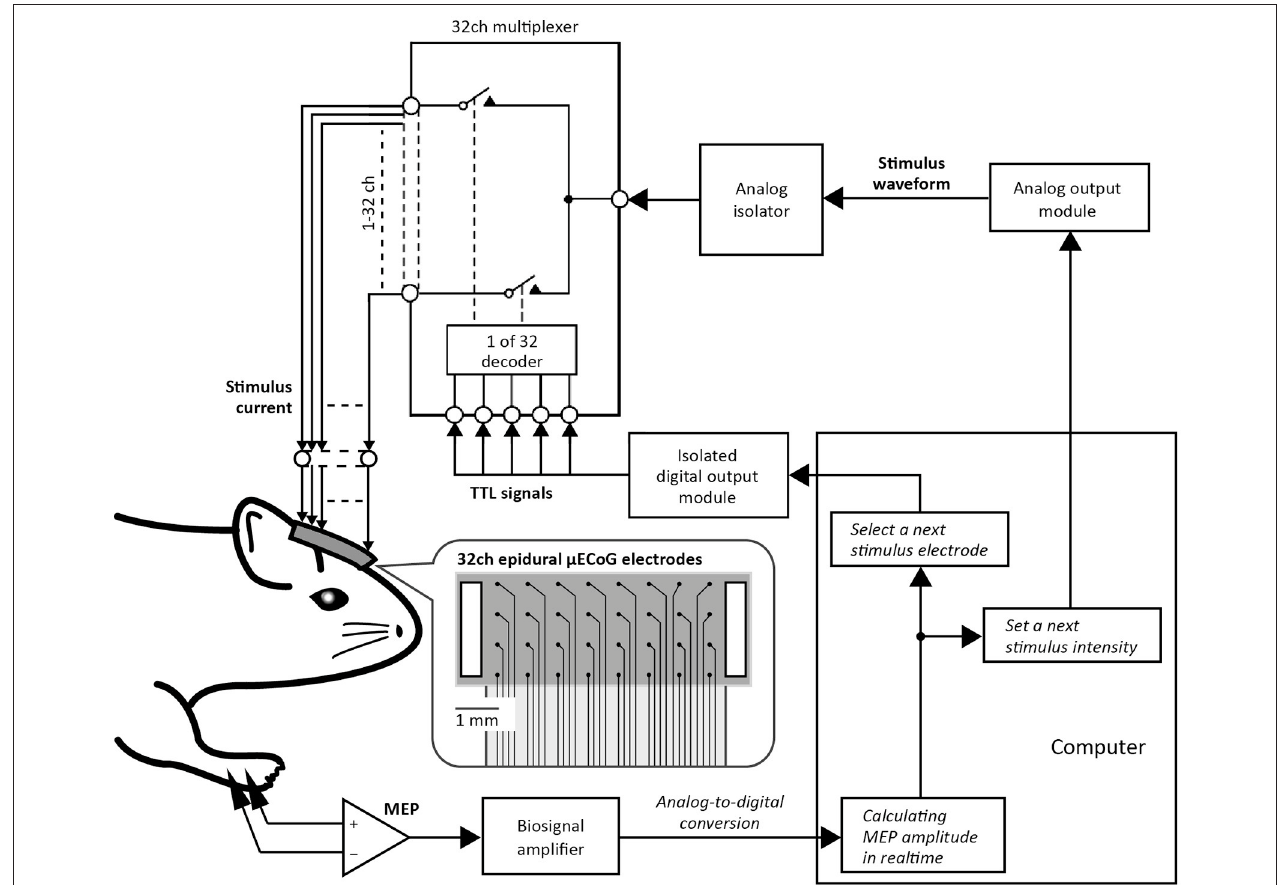
FIGURE 1 | Automatic motor mapping system. Stimulus current was applied epidurally through one of the 32 micro-electrocorticographic ( µ ECoG) electrodes placed on the rat motor cortex. In the picture of the 32ch ECoG electrode sheet, black dots represent stimulus electrodes and white boxes represent stimulus grounds. Individual electrodes for cortical stimulation were selected by a 32ch multiplexer that was controlled using transistor-transistor logic (TTL) signals sent from the isolated digital output module. The stimulus waveform (e.g., duration, polarity, and intensity) was regulated by a signal sent from the analog output module. Motor evoked potential (MEP) was then stored on a computer. Thereafter, the implemented algorithm selected the µ ECoG electrode and the intensity value of the next stimulation, depending on the previous MEP